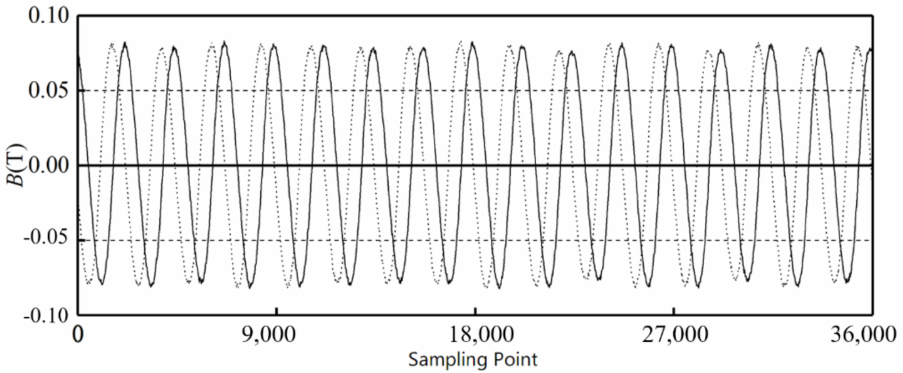
Figure 12. Signals from Hall sensors of outer alnico.